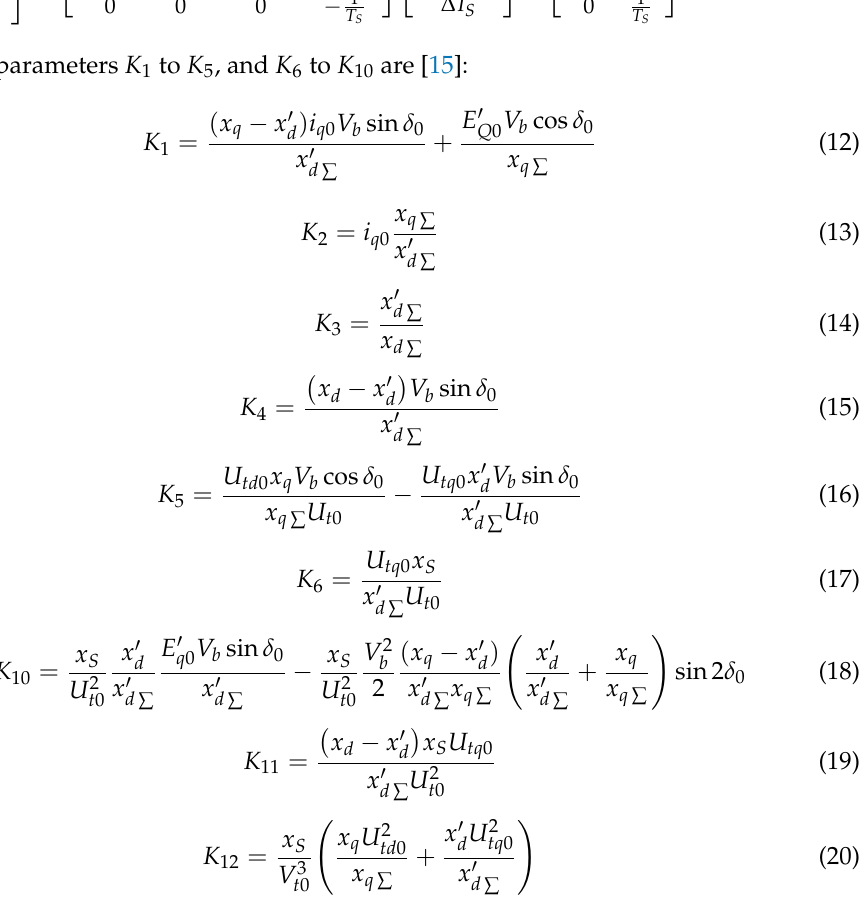
Figure 2. Figure 2.